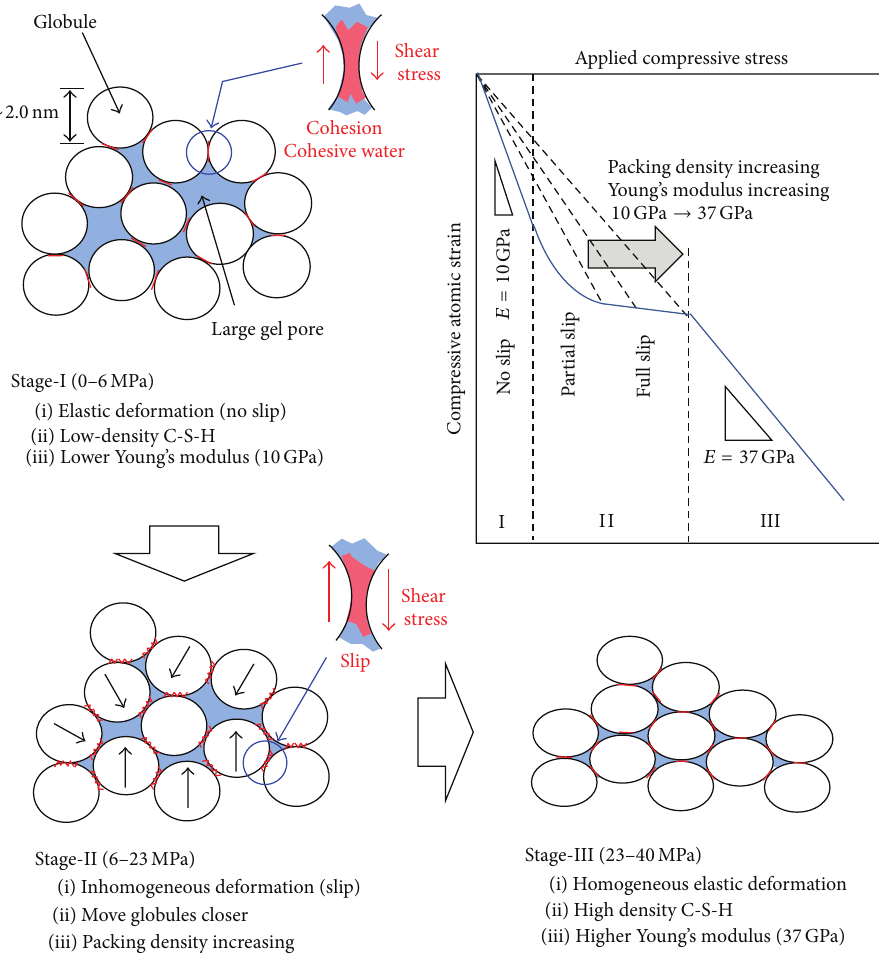
Figure 5: Schematic illustration of the deformation mechanism of C-S-H under uniaxial compression. Arrows in the globules in Stage-II indicate an image of its